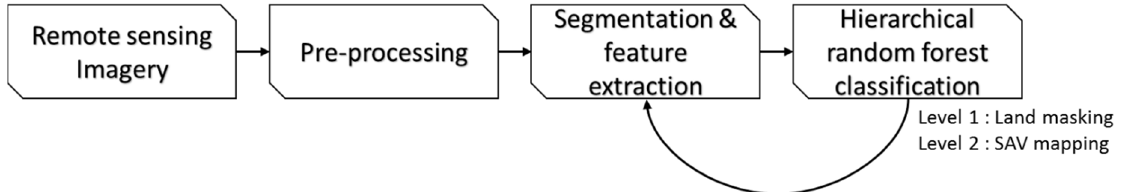
Figure 1. Typical remote sensing object-based image analysis (OBIA) workflow, where a sequence of classifications is performed on image segments (objects) based on training sets and large arrays of features.